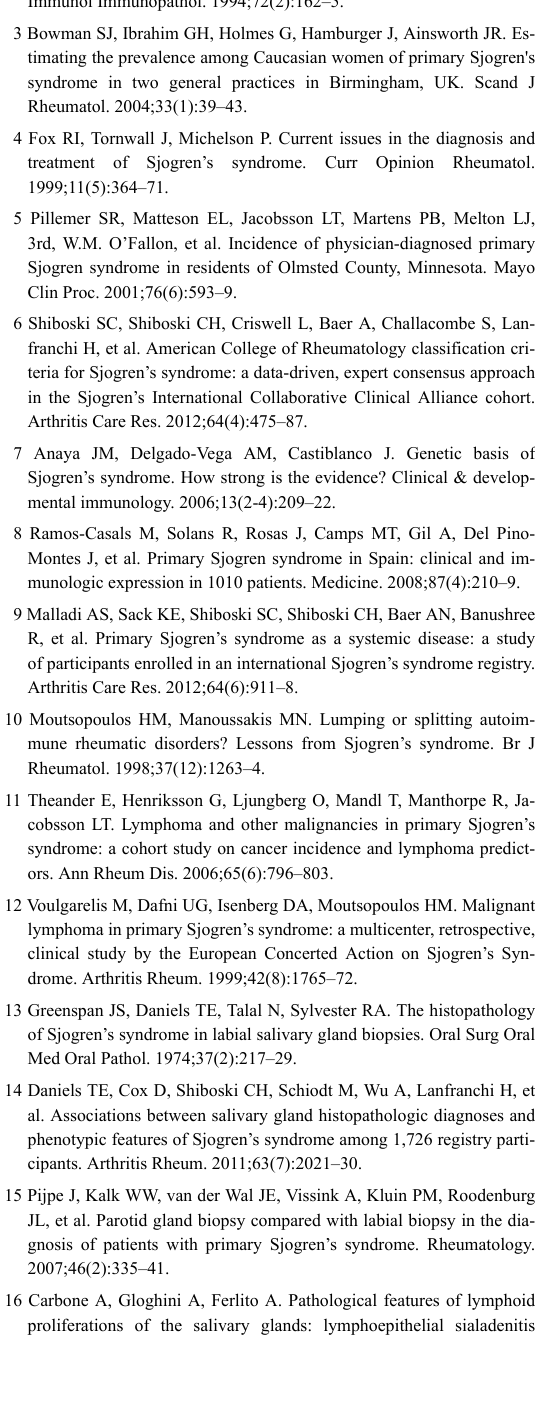
Table 3: Histological changes observed in the salivary glands following biological treatment. Measuring post-treatment lymphocytic aggregates in primary Sjögren’s syndrome